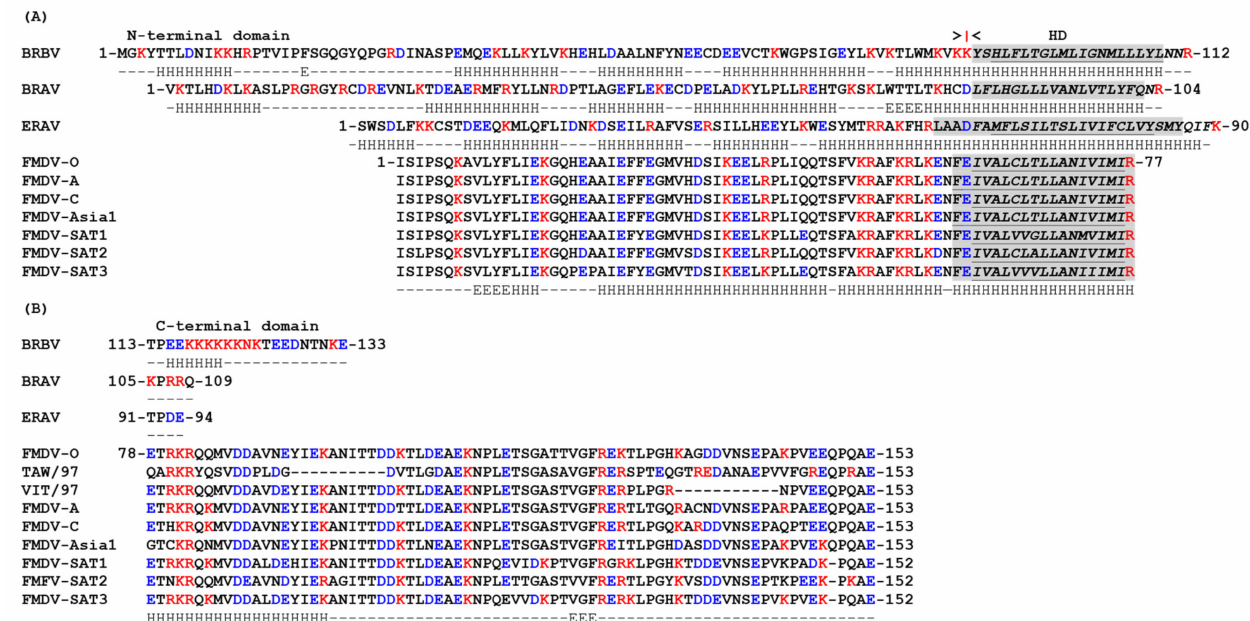
Figure 2. 3A protein alignment for selected aphthoviruses. ( A ) Alignment of the 3A N-terminal domains and HDs of selected aphthoviruses (all seven serotypes of FMDV, namely FMDV-O, -A, -C, -Asia1, -SAT1, -SAT2 and -SAT3, plus equine rhinitis A virus (ERAV), bovine rhinitis virus A and B (BRAV-1 and BRBV-1). The 3A proteins have a similar organisation that consists of a N-terminal domain, a HD that includes a predicted MBR, followed by a CTD. The sequence annotation and alignment are as described for Figure 1. For BRAV-1 only 3 (TM-PRED, HMMTOP and PHOBIUS) programs predicted an MBR and therefore no underlined sequences are shown. Secondary structure predictions were made using Jpred4 and are indicated under each sequence (H = Helix, E = extended). Very similar secondary structures were predicted for each FMDV serotype and are represented by FMDV-SAT3. ( B ) Alignment of the 3A C-terminal domain of selected aphthoviruses (as described for panel A). In addition, the CTDs for FMDV, O/TAW/97 (TAW/97) and O/VIT/2/97 (VIT/97) [87,97] are included to show the position of the internal deletions; the deleted residues are indicated by – (residues 93–102 for O/TAW/97 and 133–142 for O/VIT/2/97). The CTDs of the FMDV-SAT serotypes have one residue less than the other FMDV serotypes. The missing residues are indicated by -. Accession numbers of the sequences shown: FMDV-O AJ539141, FMDV-A AY593752, FMDV-C AY593805, FMDV-Asia1 DQ533483, FMDV-SAT1 AY593840, FMDV-SAT2 AY593849, FMDV-SAT3 AY593850, O/TAW/97 AF308157, O/VIT/2/97 AJ295002, ERAV DQ272578, BRAV-1 KP236128, and BRBV-1